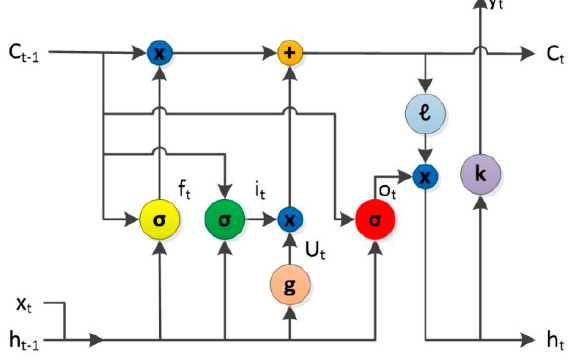
Figure 6. Long Short-Term Memory (LSTM) structure [38].